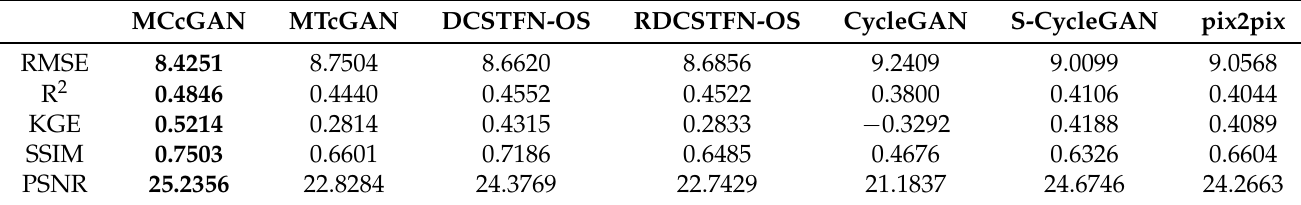
Table A4. The evaluation metrics of different methods for the red band in Area B at Time IV (the bold result is the best among the different metrics).